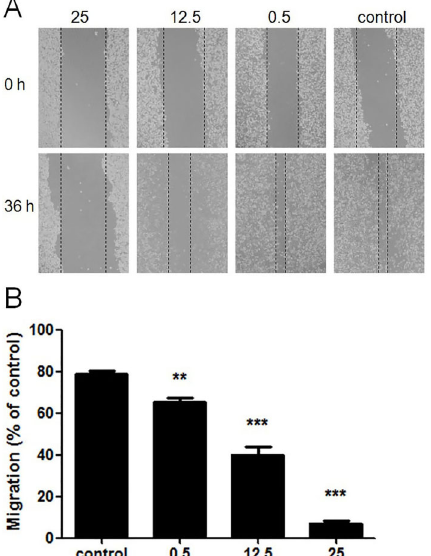
Figure 2. Suppression of wounding healing by ethanol extracts of Antrodia cinnamomea (EEA). A , A wound was made when cell con fl uence was 100% and fresh medium supplemented with different concentrations of EEA was added. Images were captured at 0 and 36 h. B , Migration distance was calculated and normalized to control that was not treated with EEA. Data are reported as means ± SD. **P o 0.01, ***P o 0.001 compared to control